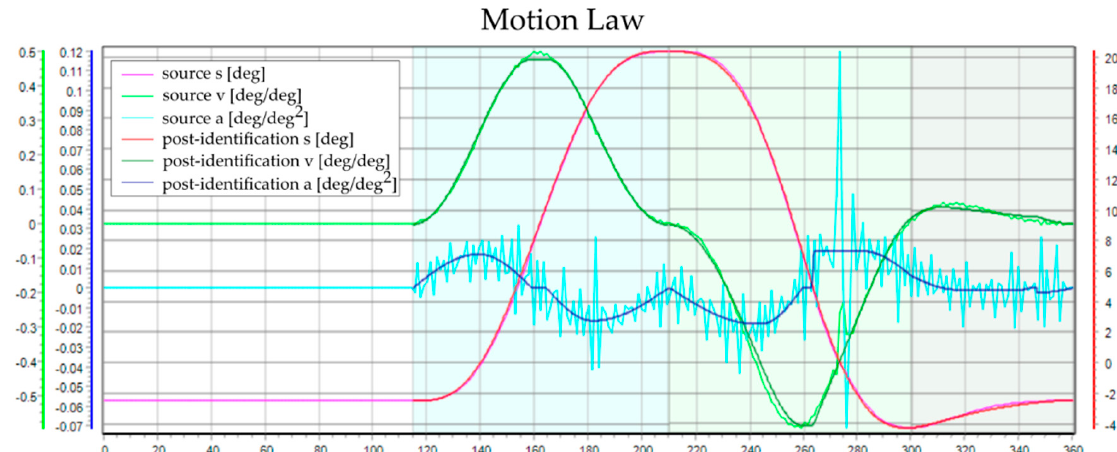
Figure 16. Comparison between the experimental law of motion (light blue) and modified trapezoidal laws for each phase (with equal coefficients values) after identification based on acceleration by adopting the DTW algorithm.